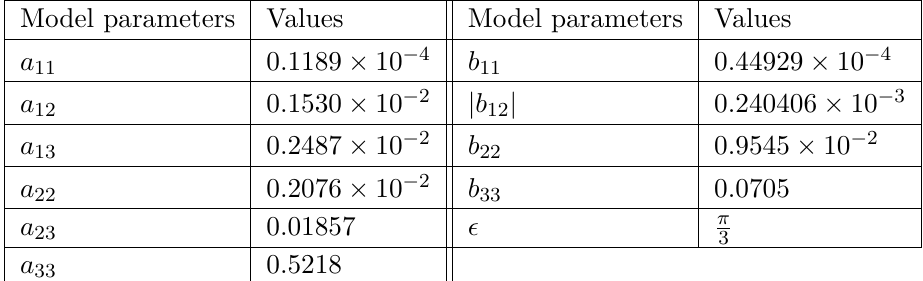
Table 4 . Parameters of the quark and charged leptons Yukawa matrices at the GUT scale with tan β = 10